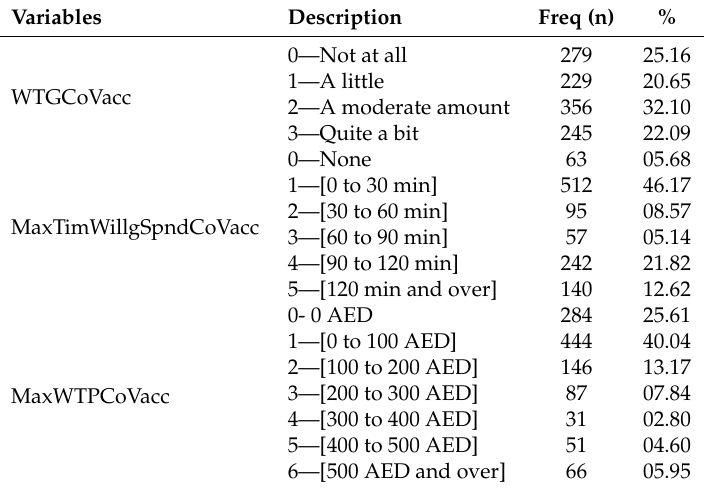
Table A1. Vaccine Outcome Variables (n = 1109).